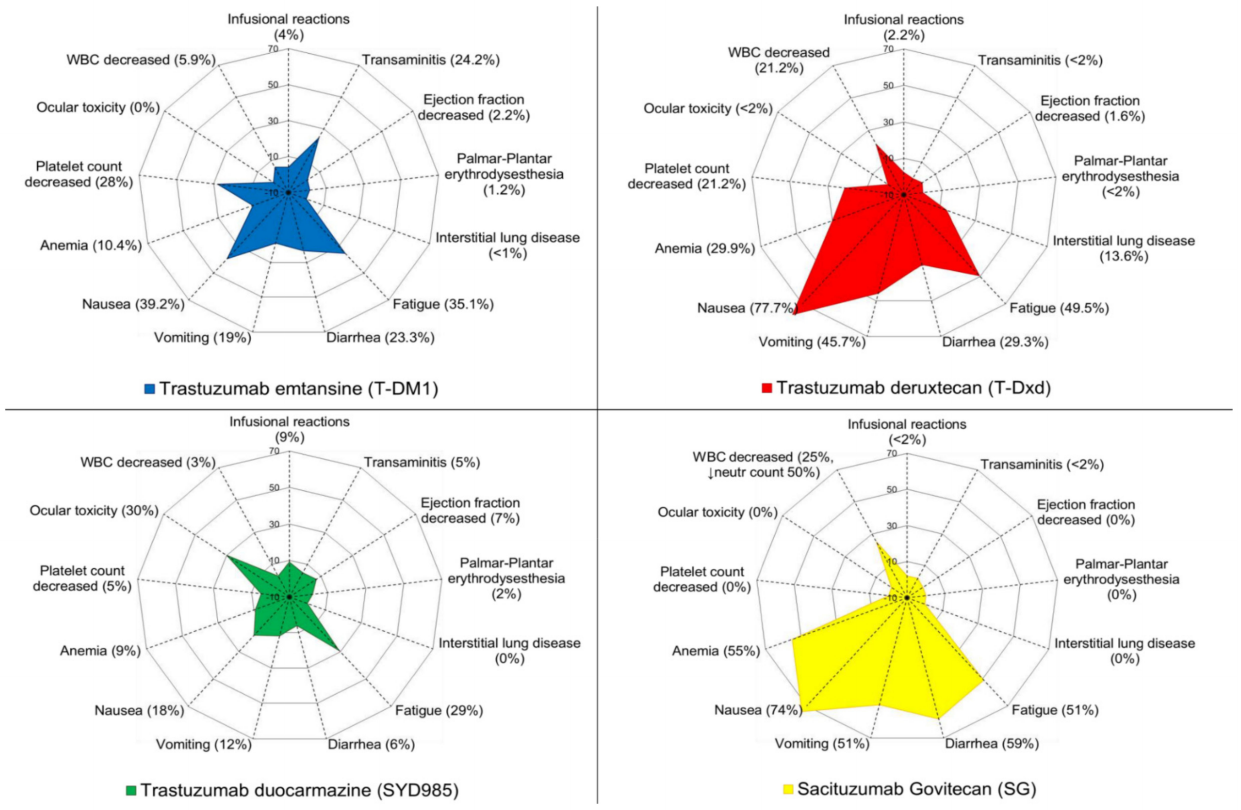
Figure 4. Toxicity profiles of the antibody–drug conjugates currently approved or in late stages of development. Ab- breviations: WBC, white blood count; T-DM1, trastuzumab emtansine; T-Dxd, trastuzumab deruxtecan; neutr, neu- trophil